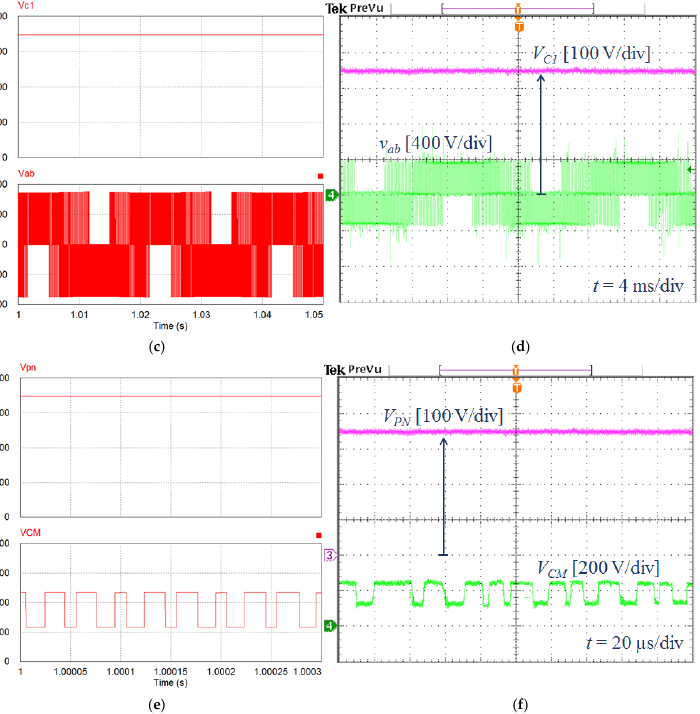
Figure 10. MAqZSI under the proposed CMV-SVM reduction method when V i = 350 V, D = 0. ( a , c , e ) Simulation results and ( b , d , f ) experimental results. From top to bottom: input voltage, output currents, capacitor C 1 voltage, v ab voltage, DC- link voltage, and CMV.